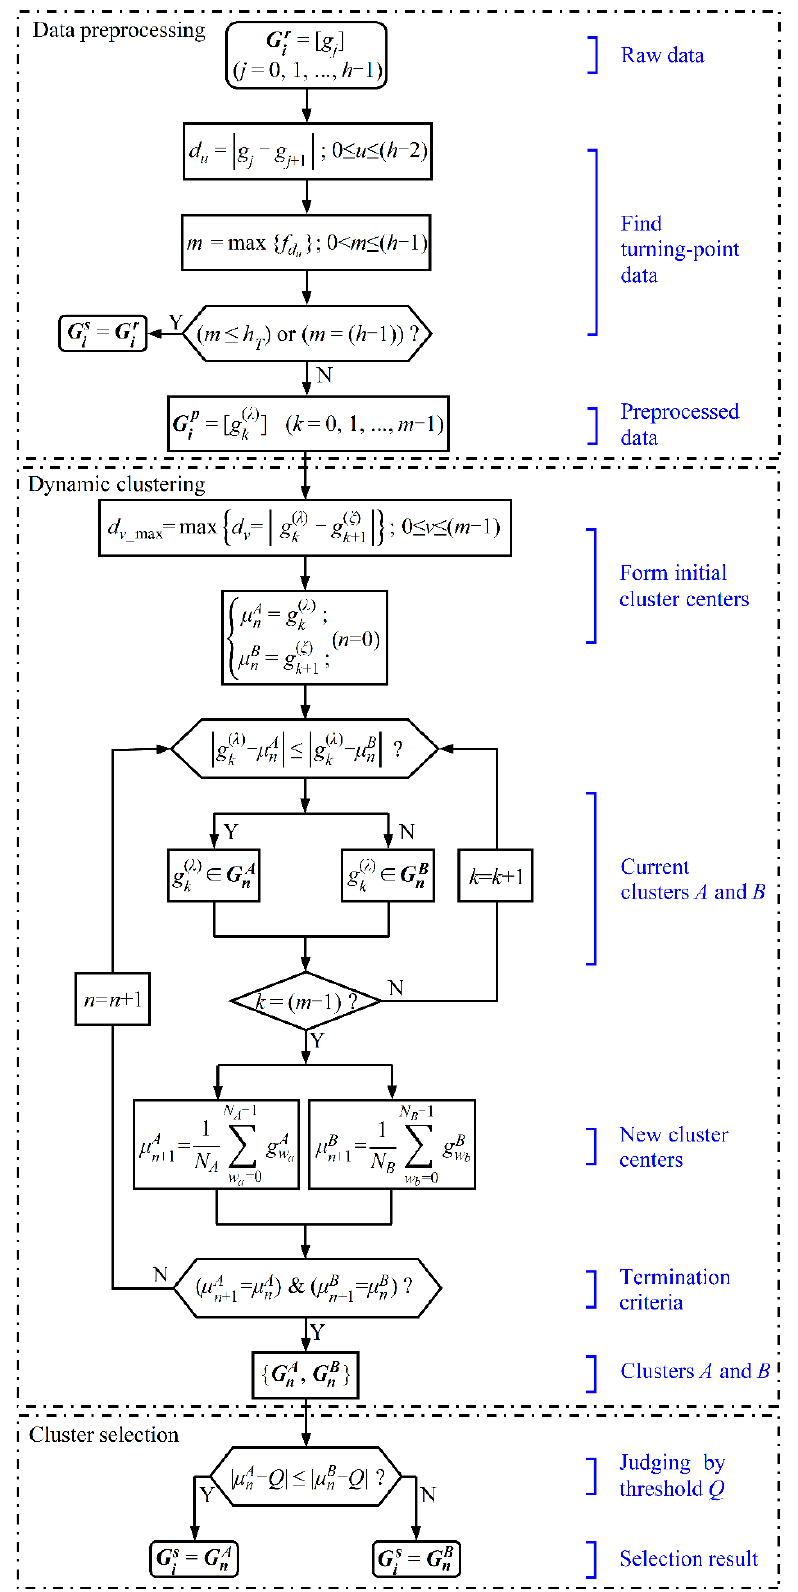
Figure 4. Schematic diagram of the ISDC algorithm.